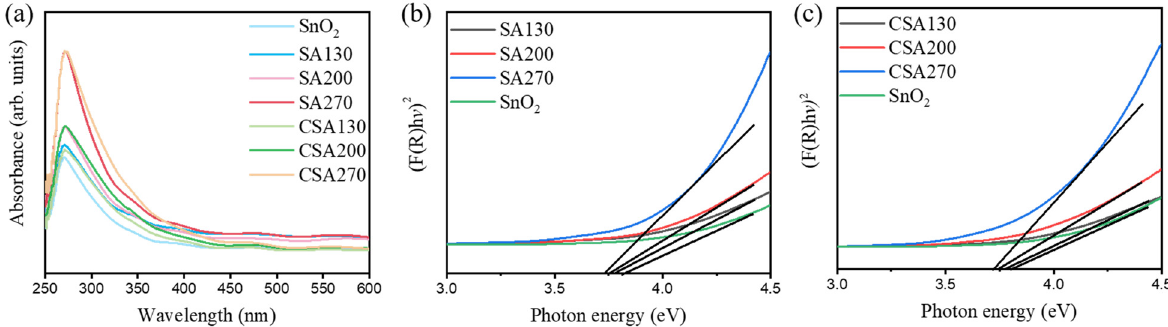
Figure 4: ( a ) UV - Vis absorption spectra of various samples. Evaluation of bandgap energies of ( b ) SA series and ( c ) CSA series thin fi lm samples. The pristine SnO 2 thin fi lm was added for comparison in each Tauc